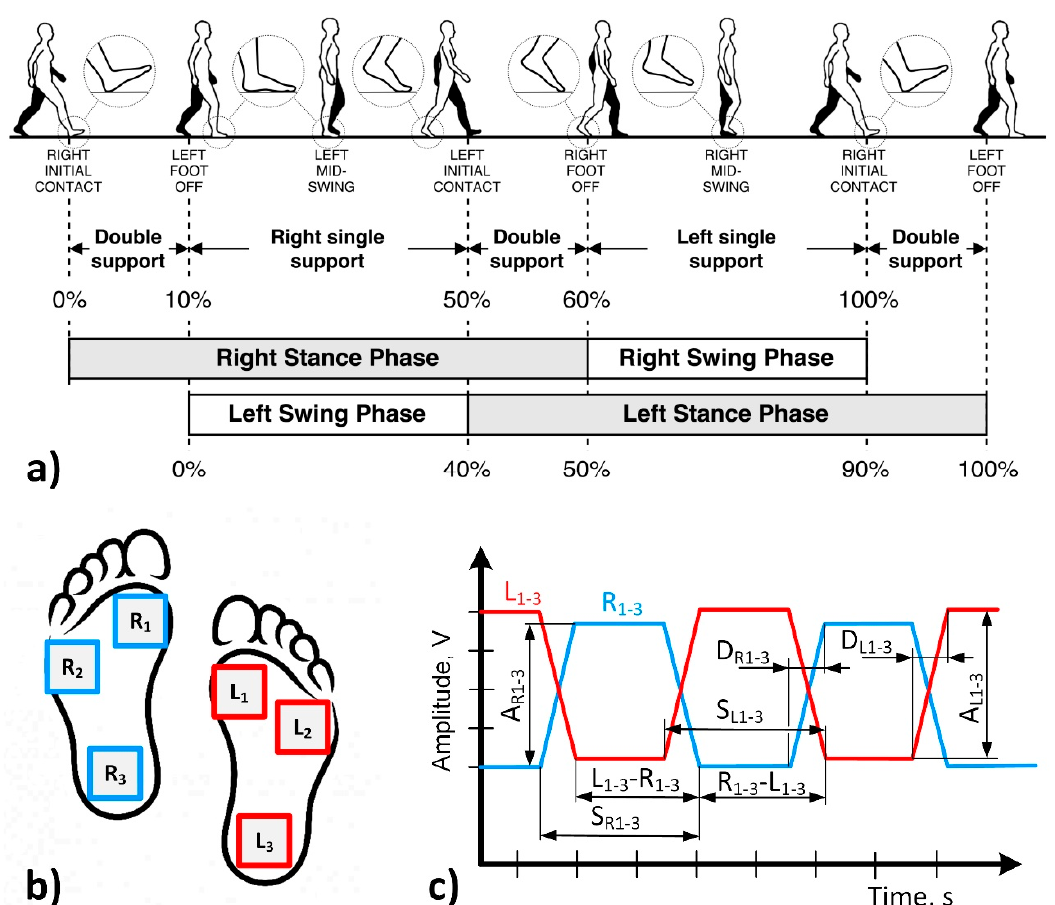
Figure 1. Scheme of human gait analysis: ( a ) human gait phases [28,29]; ( b ) sensors placement; ( c ) extraction of main parameters from sensors signals. L 1–3 ; signals from left foot sensors, R 1–3 ; signals from right foot sensors, A R1–3 and A L1–3 ; parameters representing weight distribution on the right and left feet, S R1–3 and S L1–3 ; duration of left and right stance phases, D R1–3 and D L1–3 ; stepping abruptness, L 1–3 –R 1–3 and R 1–3 –L 1–3 ; stepping unevenness.